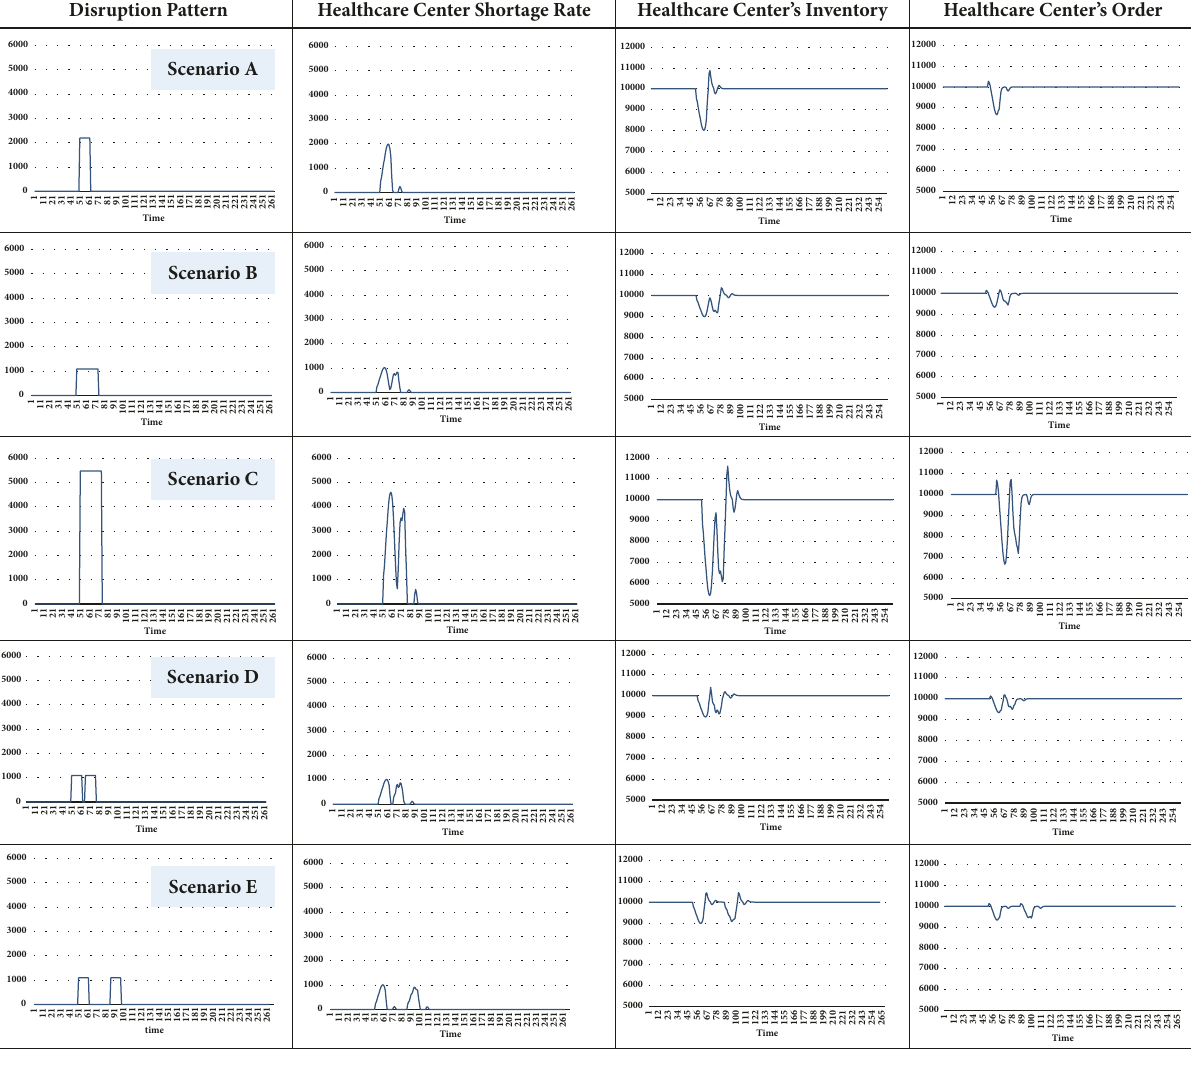
Figure 2: Inventory levels, shortage rates, and orders at health centers over time for disruption Scenarios A-E when demand is modeled